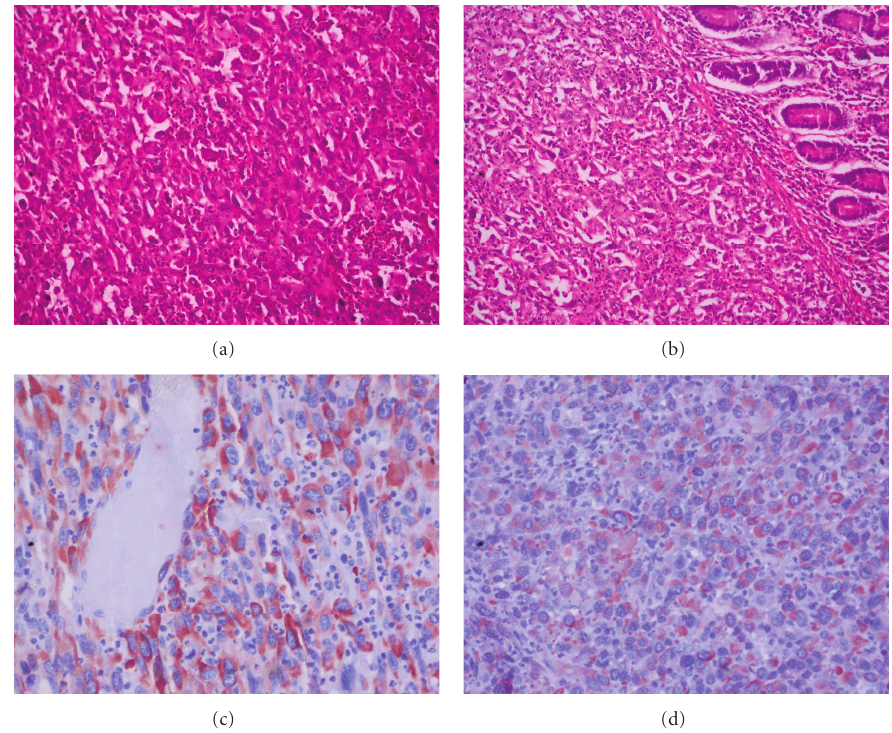
Figure 3: Pictures of histopathological and immunohistochemical results. (a) Epithelioid and fusiform shaped pleomorphic carcinoma infiltration in segments obtained from the lungs (hematoxylin-eosin, 20x magnification). (b) Submucosal neoplastic infiltration of similar morphology in segments obtained from the small intestines (hematoxylin-eosin, 20x magnification). (c) Strong cytoplasmic staining with cytokeratin in segments obtained from the small intestines (40x magnification). (d) Strong cytoplasmic staining with vimentin in segments obtained from the small intestines (40x